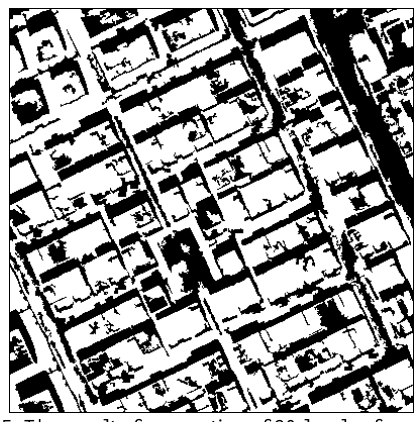
Figure 5. The result of summation of 20 levels of performing opening